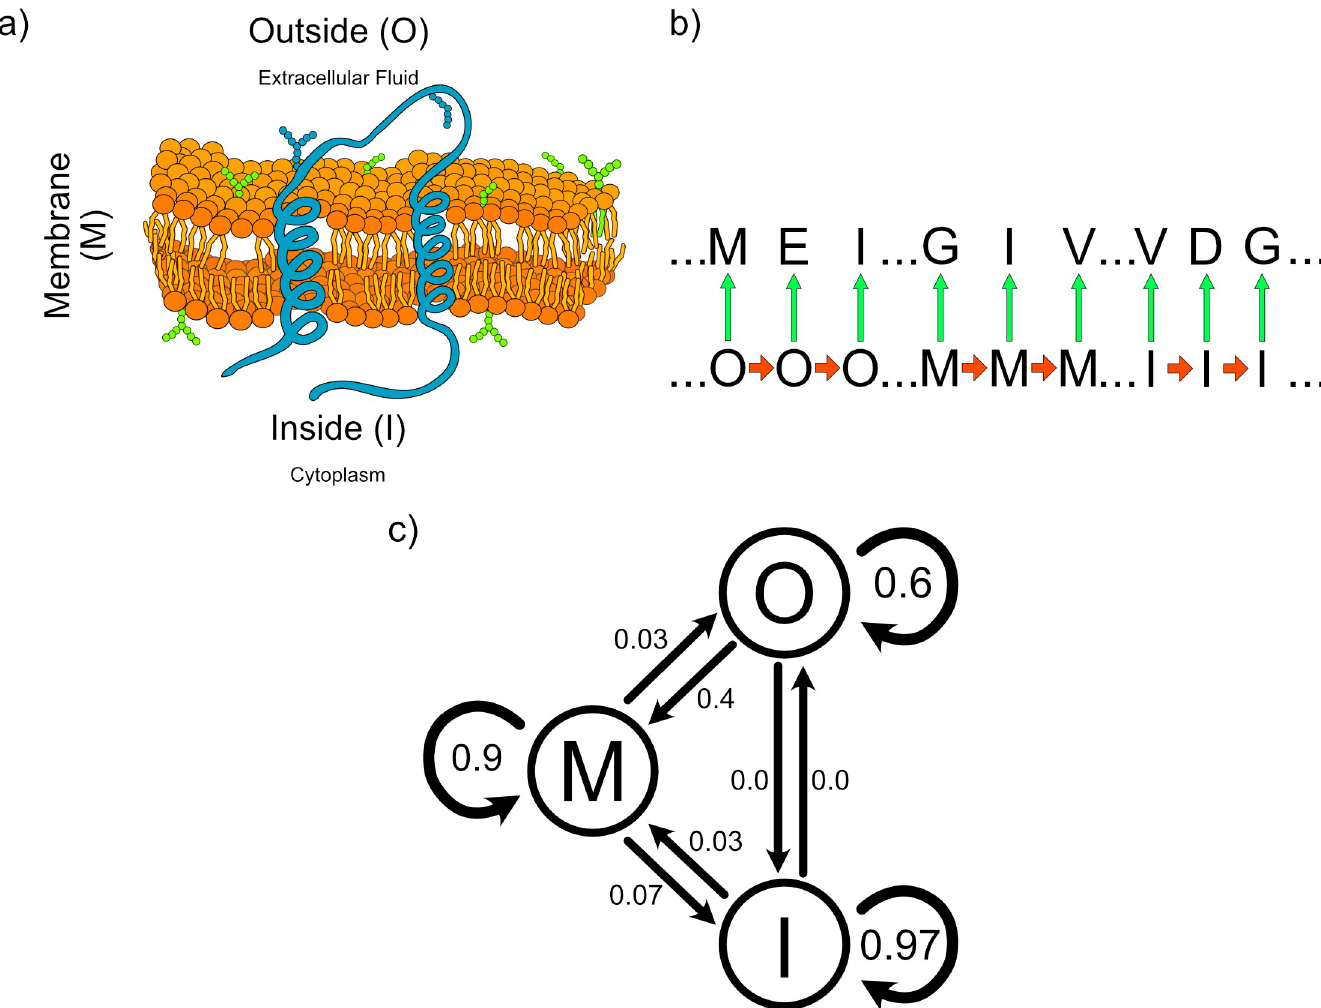
Fig 1. (A) Structural representation of a protein inserted into a membrane with several segments traversing the bilipid layer. (B) Example of an HMM process. The process starts with a hidden state, in this case I (Inside), M (Membrane), or O (Outside), which emits (green arrow) an observed state (an amino acid in 1 letter code). Then, it transitions to the next hidden state (orange arrow), which emits the next observed state, and so on. (C) Graph representation of the transition probability matrix of the HMM. The circle nodes represent the hidden states; the arrows between hidden states are transition probabilities. The emission probabilities were omitted from the graph for simplicity (S5 File). HMM, Hidden Markov